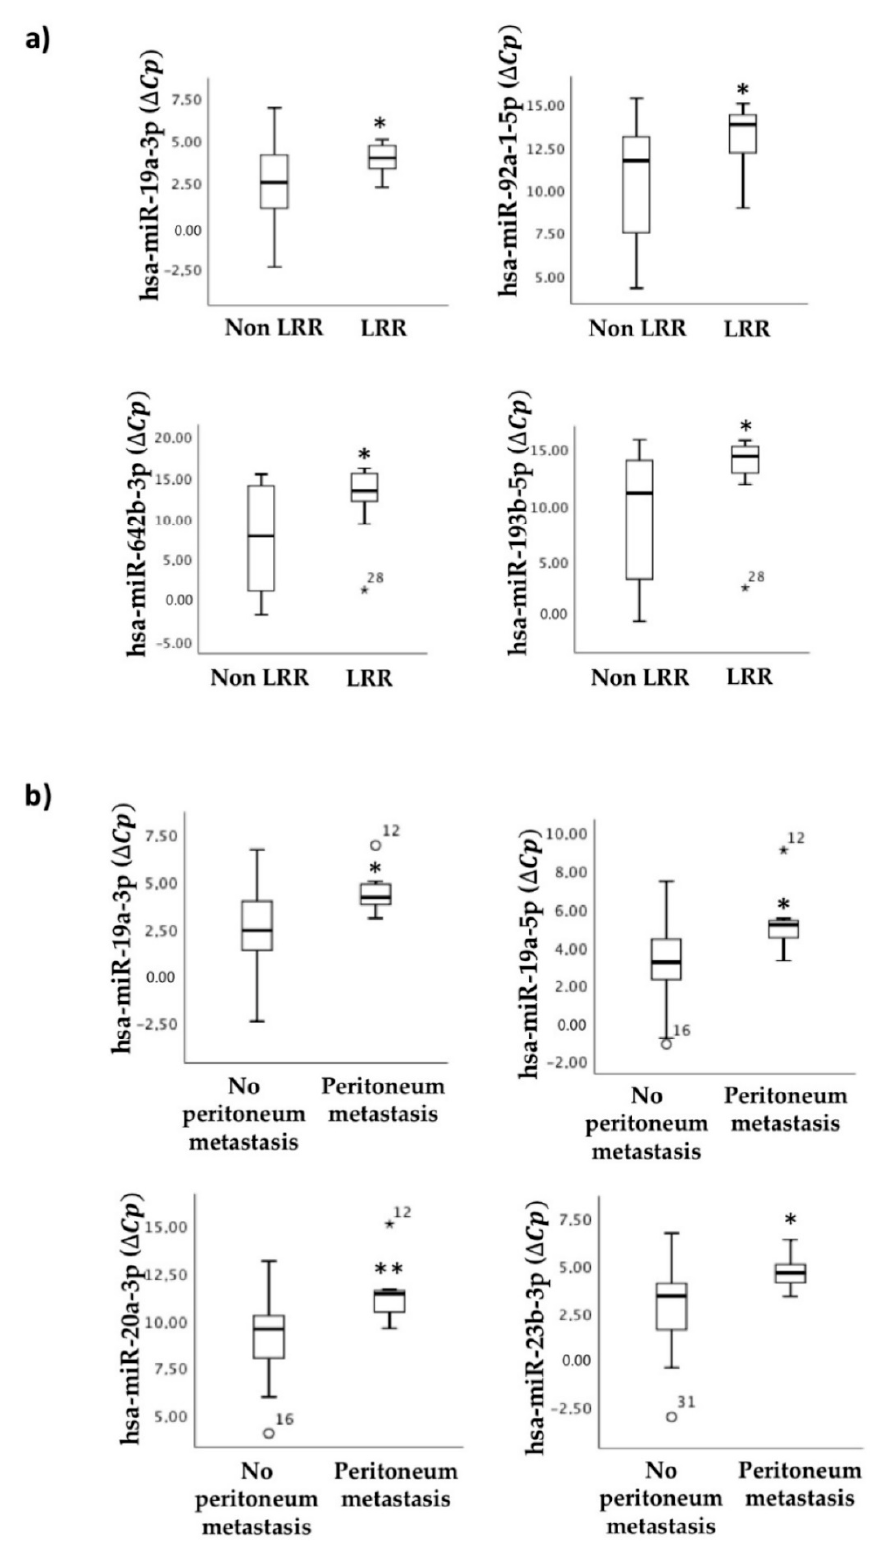
Figure 6. miRNAs determined in primary tumors correlated with metastasis localization. Statistical association of selected miRNAs determined by qRT-PCR in the primary tumors with ( a ) locoregional recurrence (LRR) (non-LRR, n = 22; LRR, n = 10) and ( b ) the presence and absence of peritoneal metastases (no peritoneal metastasis, n = 25; peritoneal metastasis, n = 7). miRNA levels are expressed as the delta-crossing threshold (DCT); the mean of miR-103a-3p Cq and miR-30c-5p Cq was used as a normalizer Cq. Only miRNAs showing a statistically significant association between